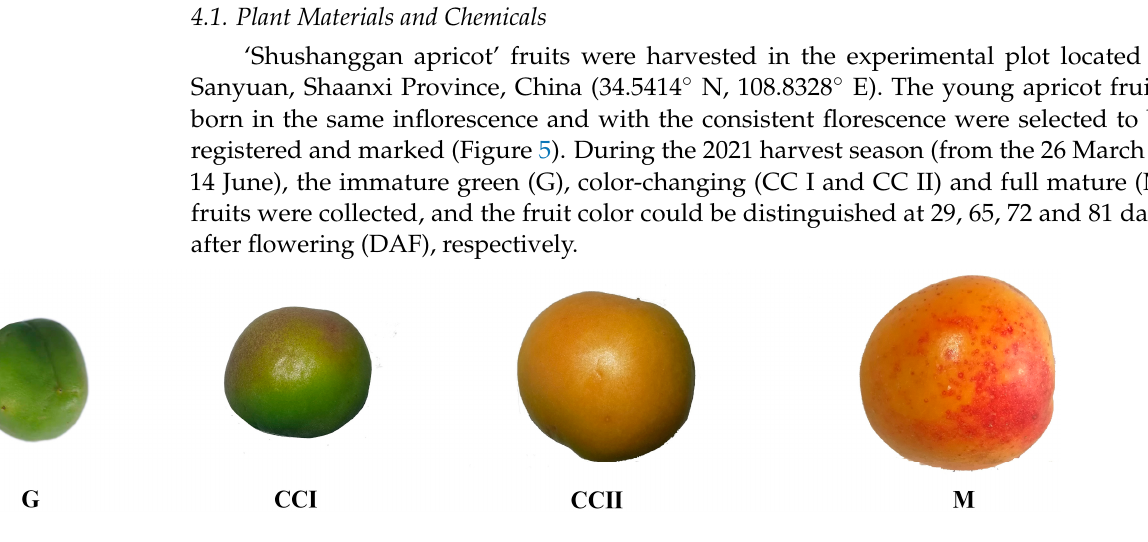
Figure 5. Morphology of ‘Shushanggan apricot’ fruits at different development stages: immature green (G); color-changing period (CCI and CCII); full mature